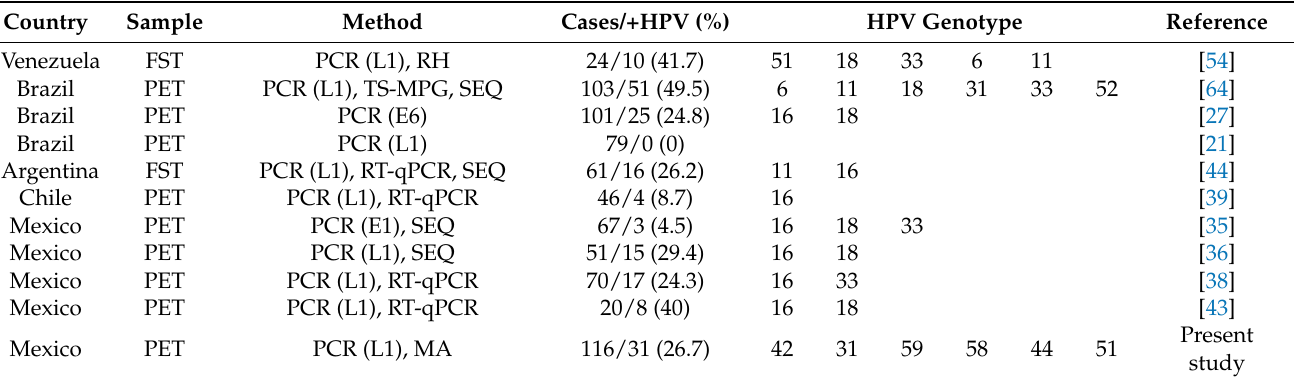
Table 6. Comparative table of HPV reported in breast tissue samples in Latin